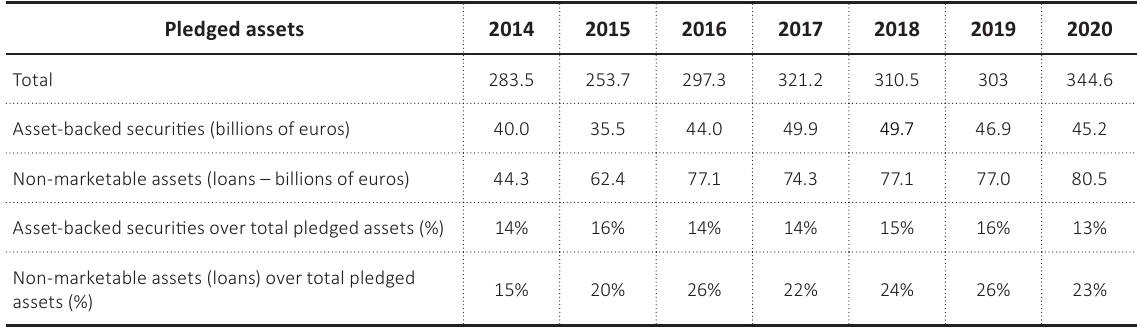
Table A3. Non-performing loans owned by Italian banks (billions of euros)